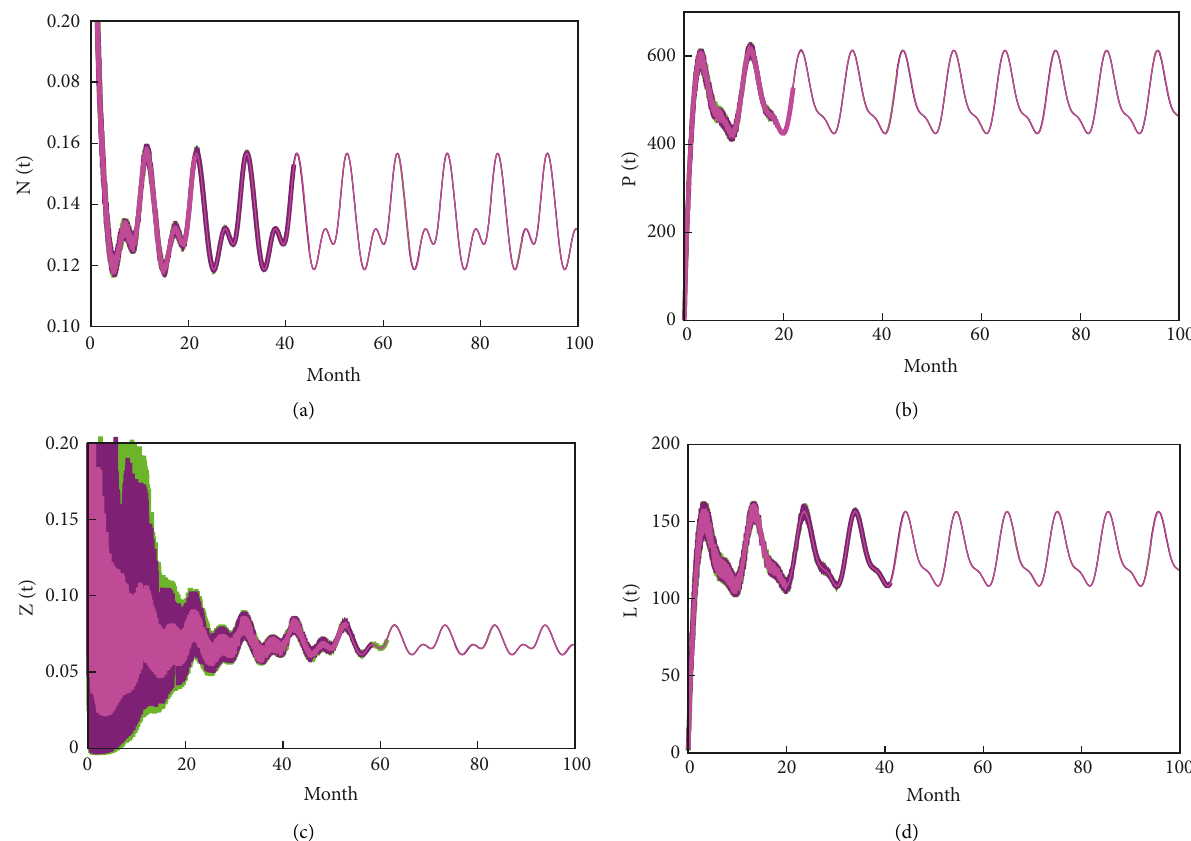
Figure 9: Phase portrait showing the time series of (a) nutrients; (b) phytoplankton; (c) zooplankton; (d) Limnothrissa miodon for model (2) and assumed initial condition: N ( 0 ) � 9 . 5 ,P ( 0 ) � 6 . 5 ,Z ( 0 ) � 3 . 5 ,L ( 0 ) � 1 . 5 (time series with colour green); N ( 0 ) � 10 , P ( 0 ) � 7 ,Z ( 0 ) � 4 ,L ( 0 ) � 2 (time series with colour purple); N ( 0 ) � 10 . 5 , P ( 0 ) � 7 . 5 ,Z ( 0 ) � 4 . 5 ,L ( 0 ) � 2 . 5 (time series with colour magenta); using the default